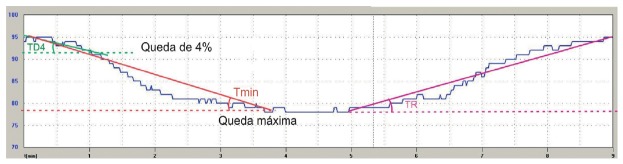
 Exemplo de inclinação das curvas. TD4: tempo para atingir uma
dessaturação de 4%. Tmin: tempo para atingir SpO2 mínima; e TR: tempo de
recuperação da SpO2.